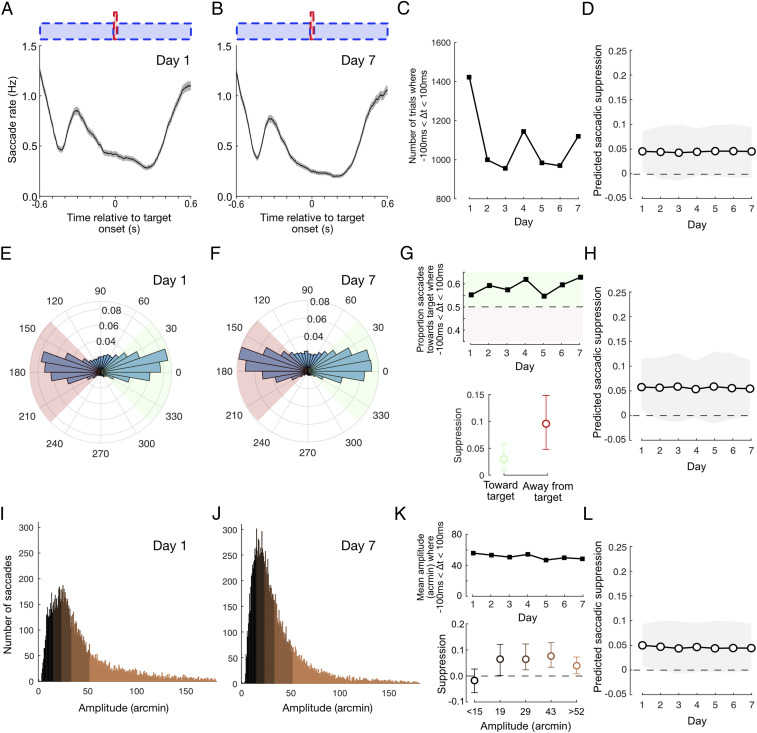
Suppression reduction is not due to learning-related changes in saccade parameters. (A and B) Saccade rate fluctuates as a function of noise and target onsets, both of which are highly predictable. This behavior arises quickly within the first day of training and continues to develop as training progresses. (C) The number of trials with saccade timings falling within the suppression interval (−100 ms < Δt < 100 ms) drops after day 1. (D) Accounting for the change in trial numbers, suppression is predicted to be flat across the week, indicating that the reduction in suppression is not due to rate changes (see Materials and Methods for further details). (E and F) The majority of saccades were oriented horizontally either toward or away from the target. (G) The proportion of target-oriented saccades during the suppression interval increased modestly during training (Top) and suppression was slightly lower for target-oriented saccades (Bottom). (H) Suppression predicted from the change in orientation ratio decreased only slightly across the week and did not account for the magnitude of suppression reduction that we observed. (I and J) Histograms of saccade amplitude on days 1 and 7. (K) Median saccade amplitude during the suppression interval dropped slightly across the week (Top), and there were differences in suppression magnitude depending on saccade amplitude (Bottom). (L) Suppression predicted from the change in saccade amplitude was flat across the week, indicating that the reduction in suppression is not due to changes in amplitude. All error bars show 95% CIs.